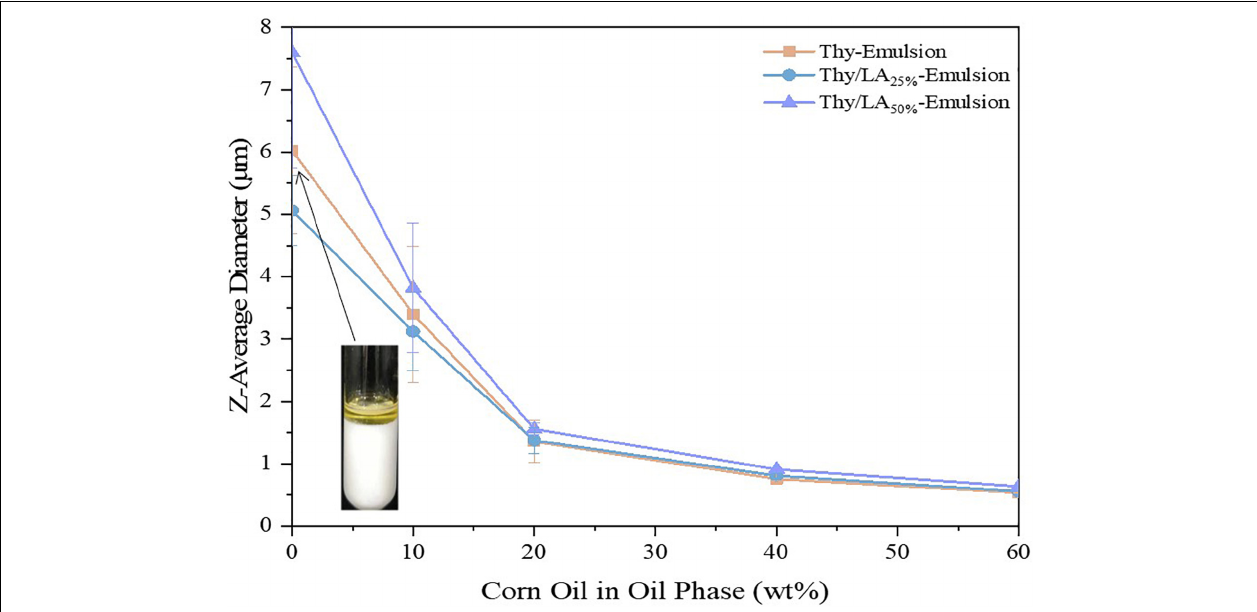
FIGURE 2 | Effect of corn oil concentration (0–60 wt%) on the mean particle sizes of Thy/LA 25% -Emulsion, Thy/LA 50% -Emulsion, and Thy-Emulsion. The photo in the graph shows that Thy-Emulsion appeared oil separation (0% corn oil). n = 6.